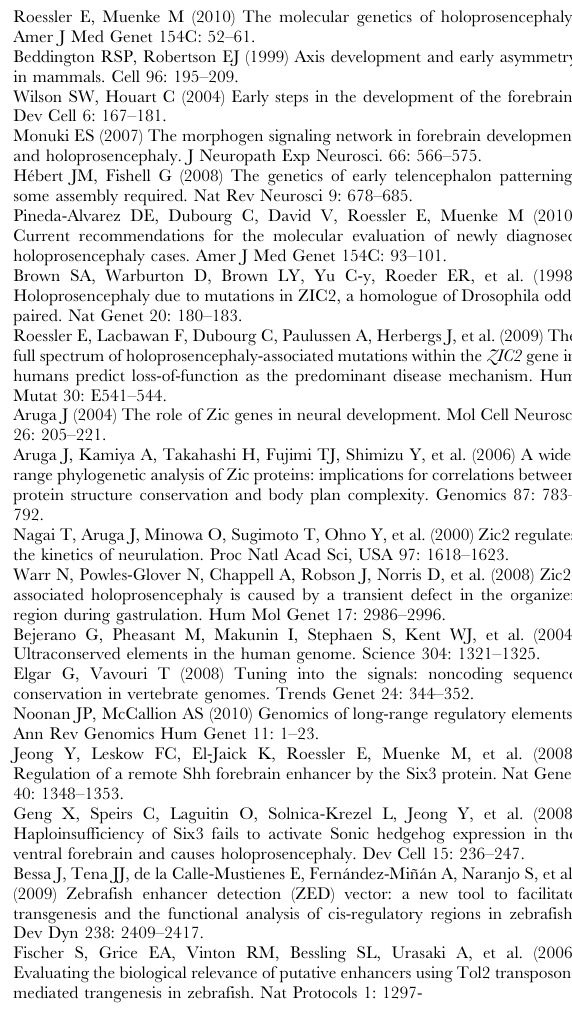
Figure S4 Evaluation of ZIC2 3 9 UTR elements in